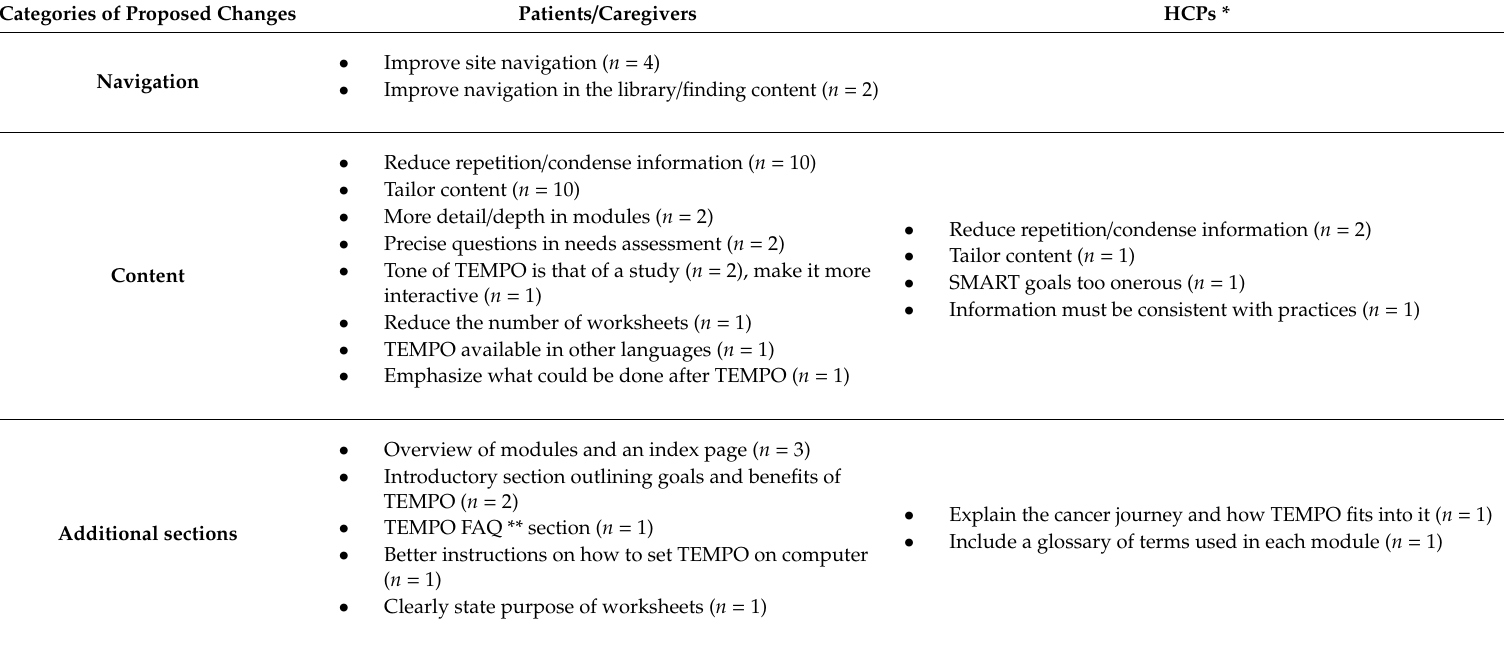
Table 3. Suggested Improvements to